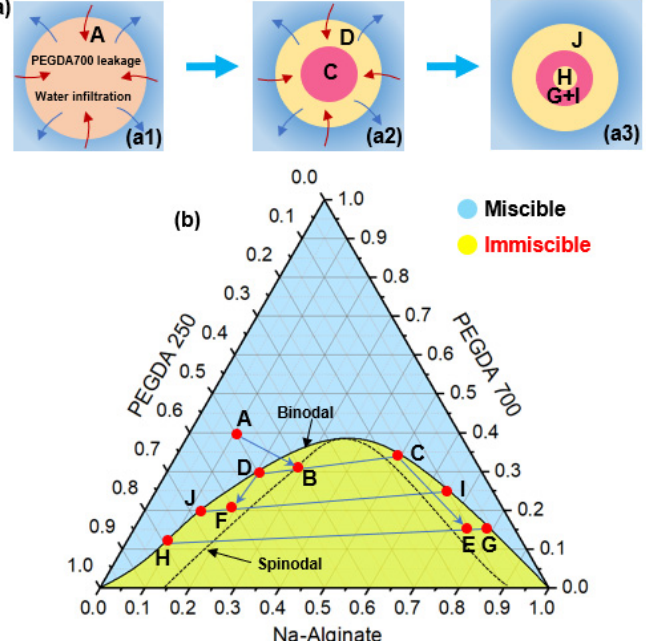
Figure 4. ( a ) Schematic of the change process of emulsion droplets in phase separation: single ( a1 ), double ( a2 ) and triple ( a3 ) emulsion. ( b ) Ternary phase diagram for analyzing the phase separation process. The blue region means that the three solutions were miscible at that volume ratio, and the yellow region indicates that the three solutions were immiscible at that volume ratio.